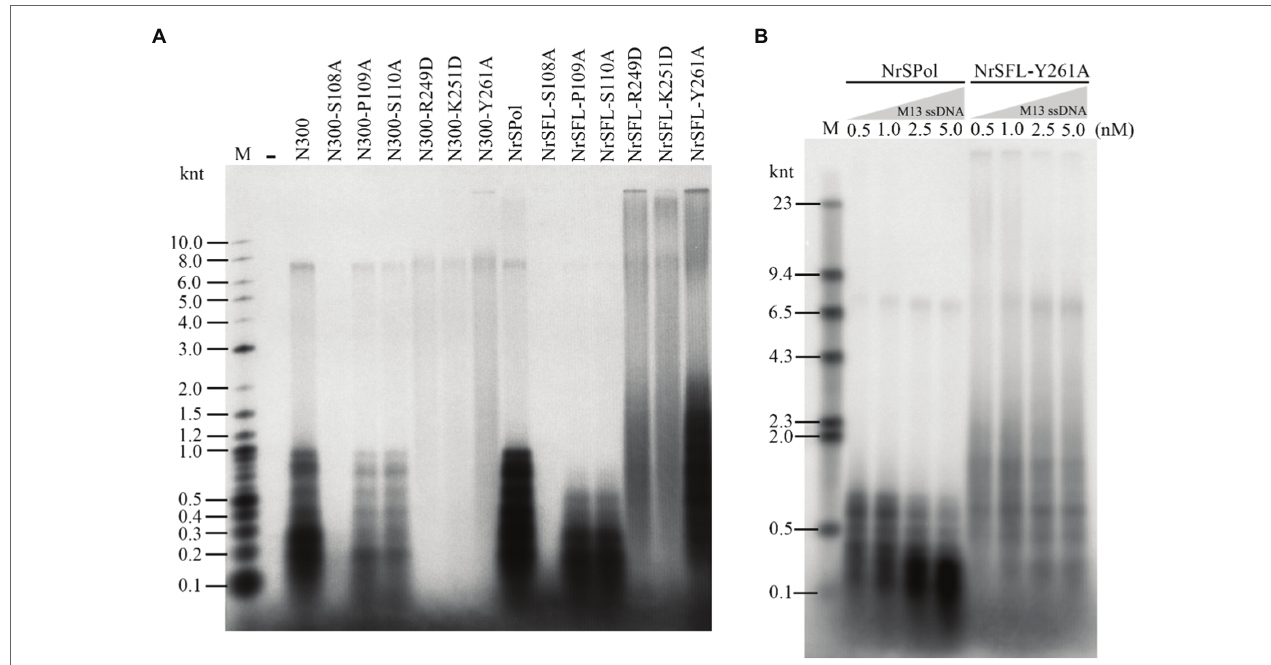
FIGURE 4 | de novo DNA synthesis on the M13 ssDNA template by NrSPol, N300, and their mutants. (A) Reactions contained 1 nM M13 ssDNA and 500 nM NrSPol, N300, or their mutants, and were incubated for 30 min at 50 ° C. The products were separated on a 1% alkaline agarose gel. (B) Reactions contained 200 nM NrSPol or NrSFL-Y261A and various concentrations of M13 ssDNA and were incubated for 30 min at 50 ° C. The products were separated on a 0.6% alkaline agarose gel. Data in the figure are representative of at least two independent